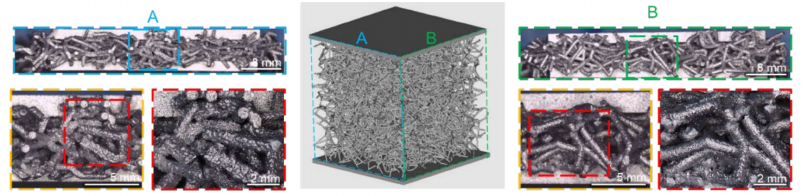
Figure 11. Failure analysis on two surfaces of the 0.75 mm beam diameter Voronoi lattice (relative density of